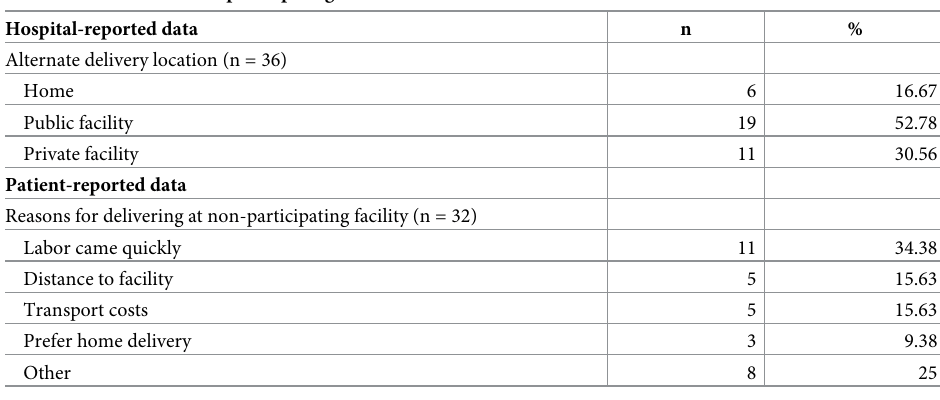
Table 2. Deliveries at non-participating